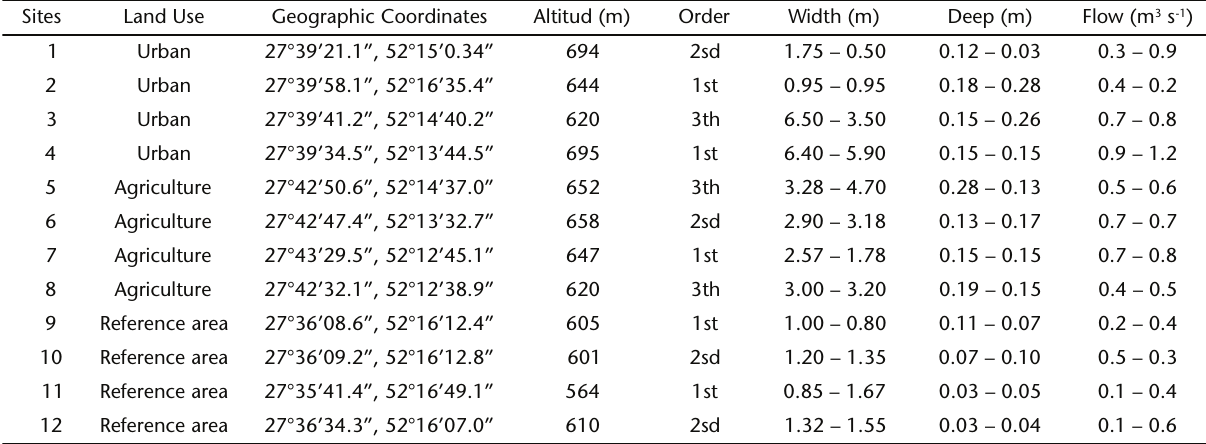
Table I. Characteristics of the sampling sites in Erechim, Rio Grande do Sul state.